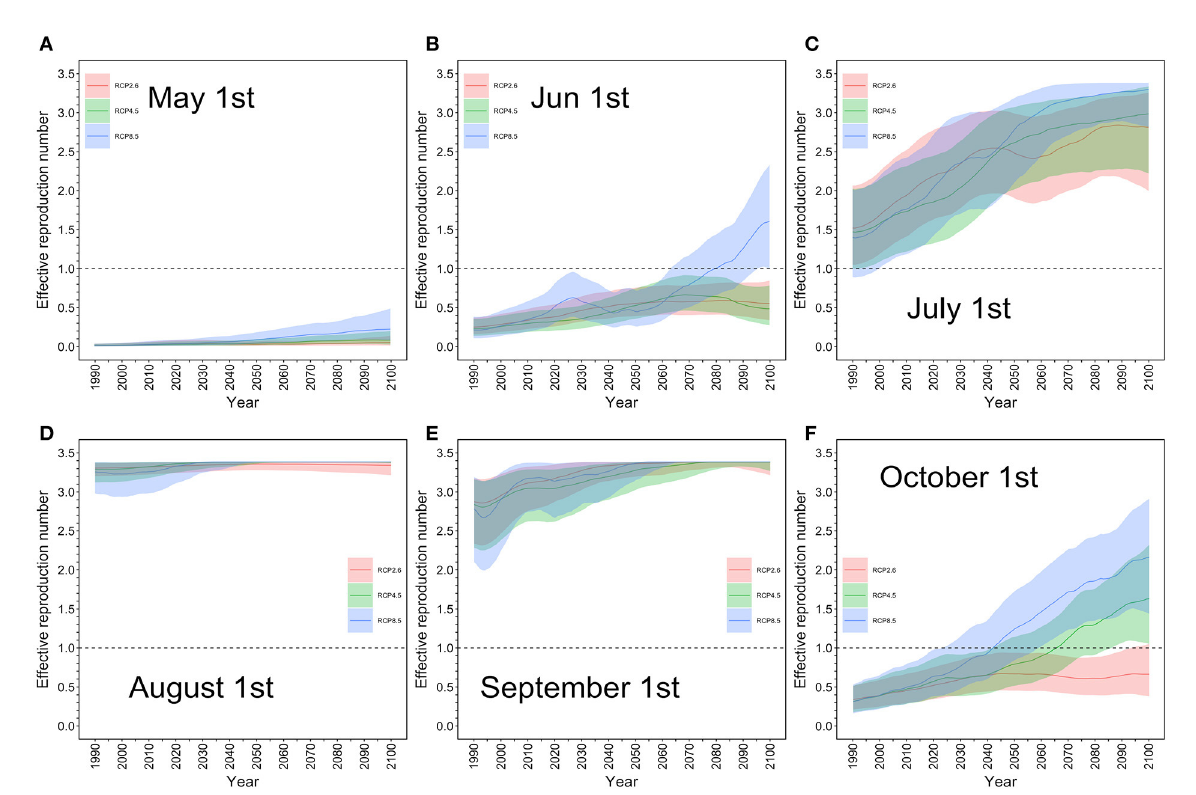
FIGURE2 Projected effective reproduction number for each RCP scenario in Tokyo: May–October. The estimated effective reproduction number from May 1 to October 1 based on the MIROC-6 model is shown. The thick line represents the expected value, and the upper and lower shaded areas are the effective reproduction number with the 95% confidence interval based on the 95% confidence interval of daily average temperature. (A) Red is the RCP 2.6 scenario, green is the RCP 4.5 scenario, and blue is the RCP 8.5 scenario; (A) May 1, (B) June 1, (C) July 1, (D) August 1, (E) September 1, and (F) October 1. The maximum value of the effective reproduction number was 3.4 in the model, and there was little difference in the impact between the scenarios for August and September, the summer season in Japan. Even in the most pessimistic scenario, RCP8.5,